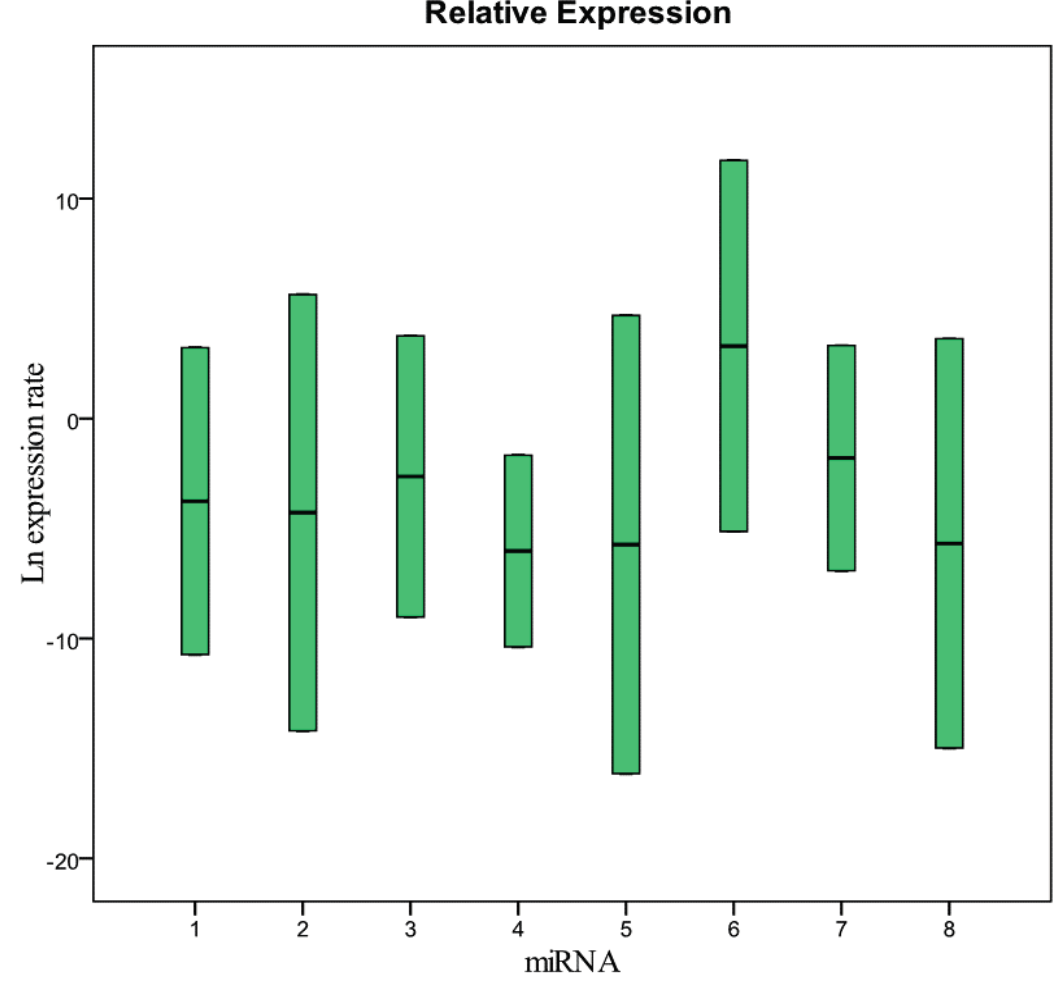
Figure 4. Relative expression (concentration) of the miRNAs analyzed in this study in samples collected in 1999 and frozen at − 80 °C compared with fresh samples. 1 = miR-125b-5p; 2 = miR-425-5p; 3 = miR-200b-5p; 4 = miR-200c-3p; 5 = miR-579-3p; 6 = miR-212-3p; 7 = miR-126-3p; 8 =